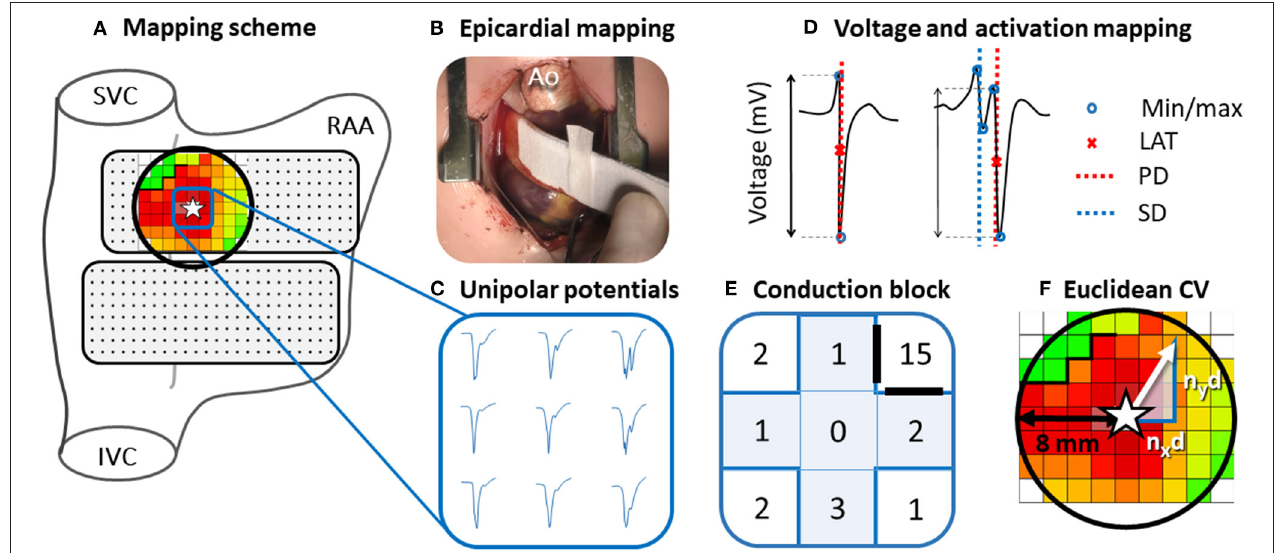
FIGURE 1 | Epicardial mapping of the SAN. Projection of the 192-unipolar electrode array on a schematic posterior view of the right atrium (A) and intraoperative image of the mapping procedure (B) . An area with a radius of 8mm around the SAN-FAP origin (star) is selected (black circle). Typical examples of nine unipolar potentials obtained at the center of the SAN-FAP are shown outside the mapping scheme (C) . These potentials are classified according to the number of deflections and potential voltage is determined as the peak-to-peak amplitude of the steepest (primary) deflection (D) . Five potentials directly surrounding the SAN-FAP origin (blue highlighted plus) are used to characterize potentials at the origin of SAN activation (E) . Conduction block is defined as a difference in local activation times (conduction time) between adjacent electrodes ≥ 12ms. The Euclidean CV is analyzed by calculating the conduction times between the SAN-FAP origin and the neighboring electrodes in superior, caudal, lateral and medial direction divided by the distance n x d and n y d (F) . SVC, superior vena cava; IVC, inferior vena cava; RAA, right atrial appendage; Ao, aorta; LAT, local activation time; PD, primary deflection; SD, secondary deflection; CV, conduction